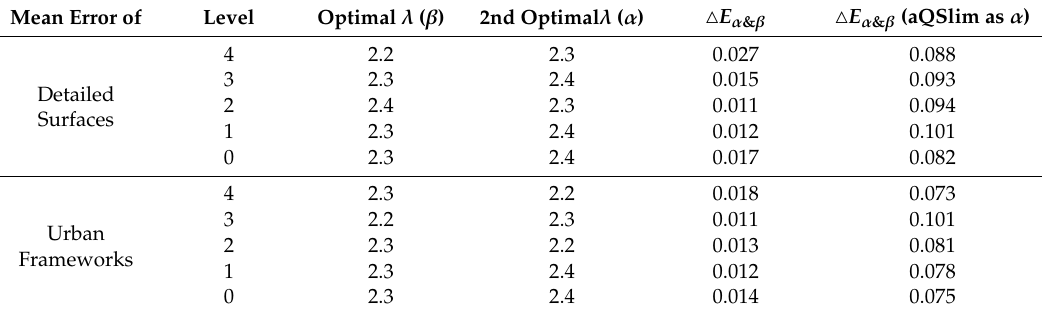
Table 1. Optimal choice of curvature indicator of mDVDC for tile